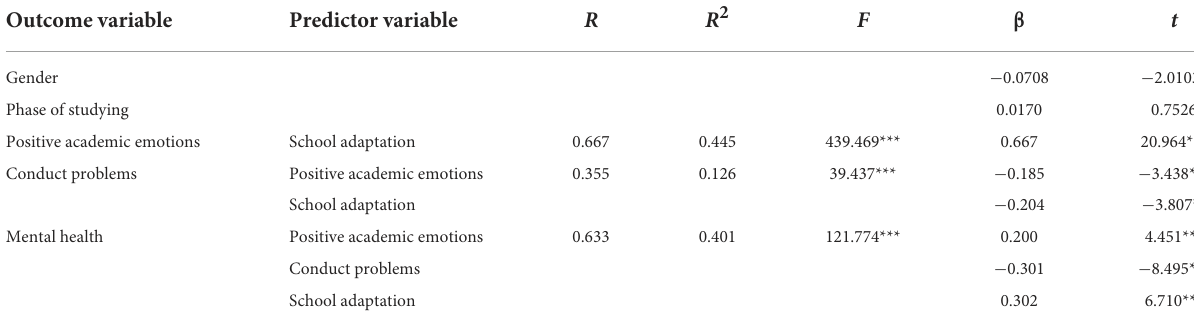
TABLE 3 The effect of school adaptation on mental health of immigrant adolescents: Chain mediation regression analysis.